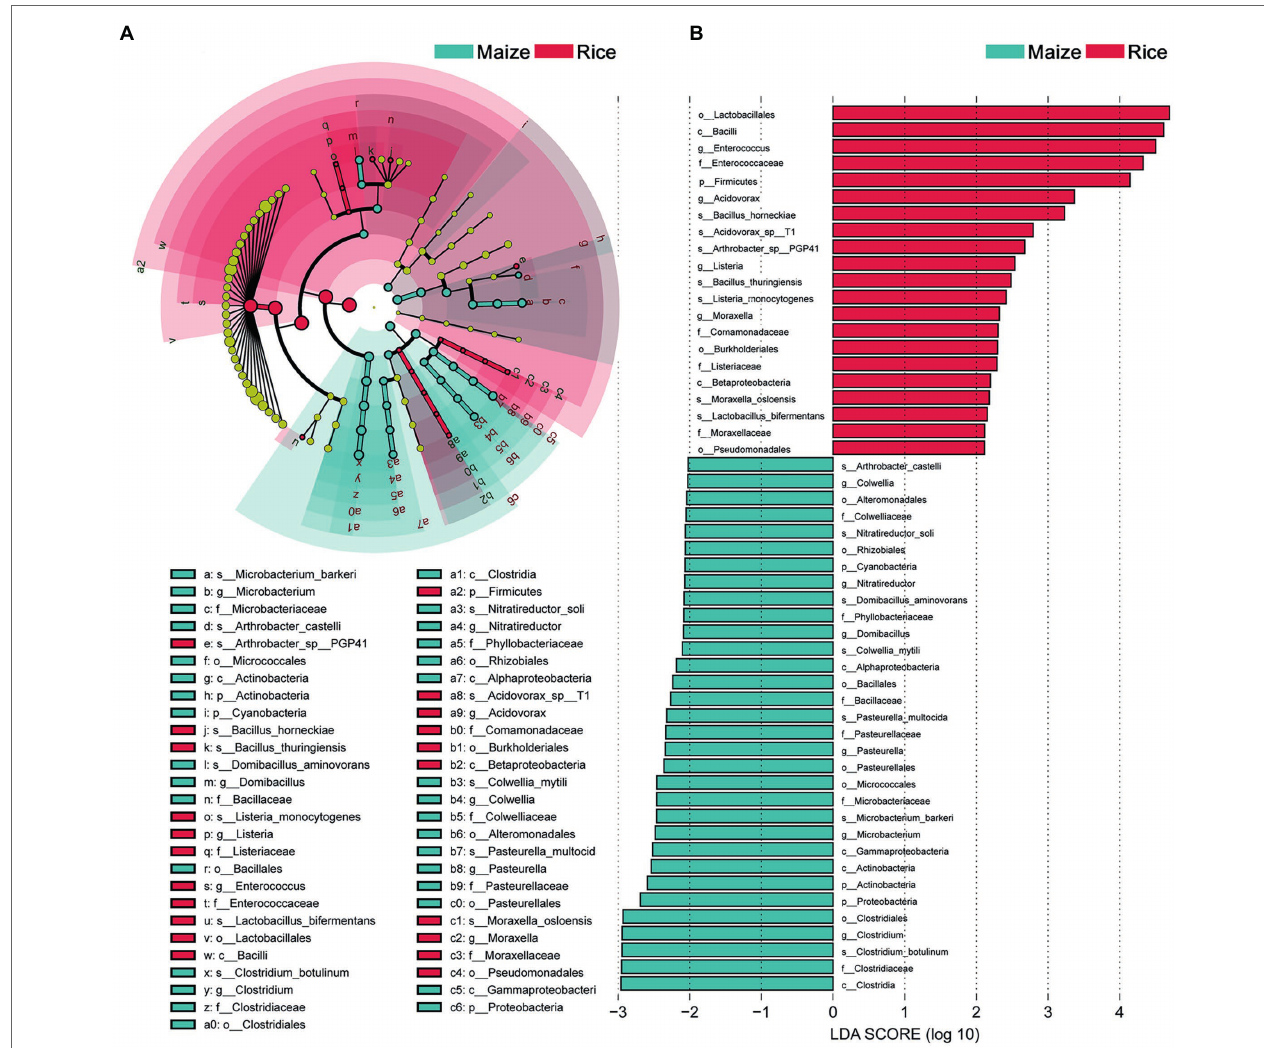
FIGURE 4 | Comparison of microbial variations using the linear discriminant analysis effect size (LEfSe) online tool. (A) Cladogram for taxonomic representation of significant differences between treatments ( p < 0.05). (B) Histogram of the LDA scores for differentially abundant features between treatments. The threshold on the logarithmic LDA score for discriminative features was set to 2.0. Differences are represented in the color of the most abundant